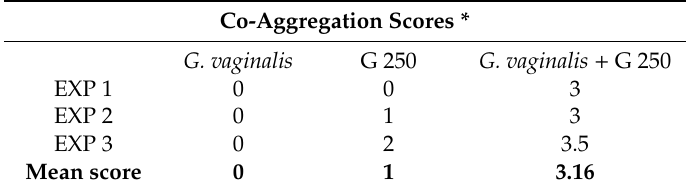
Table 1. Scores of G. vaginalis and L. rhamnosus GG (G 250)